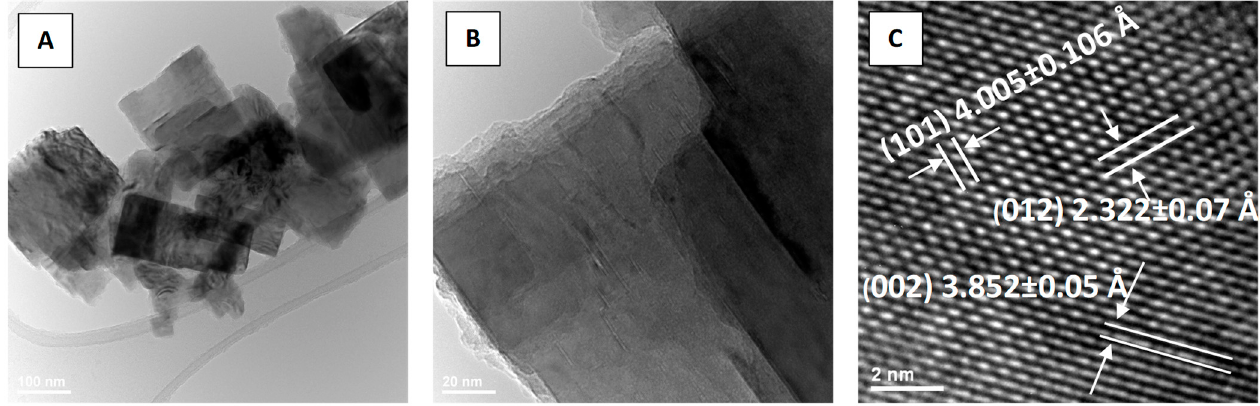
Figure 13. TEM images ( A , B ) and HR ‐ TEM ( C ) image for particles of the K8N2_250_30 sample.